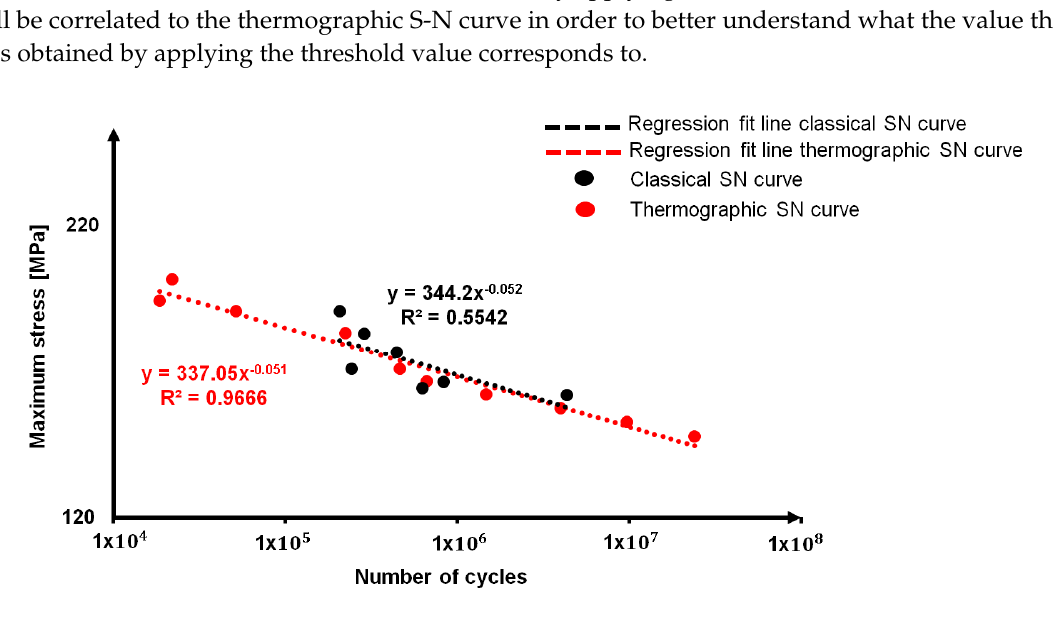
Figure 11. Classical S-N curve and thermographic S-N curve.